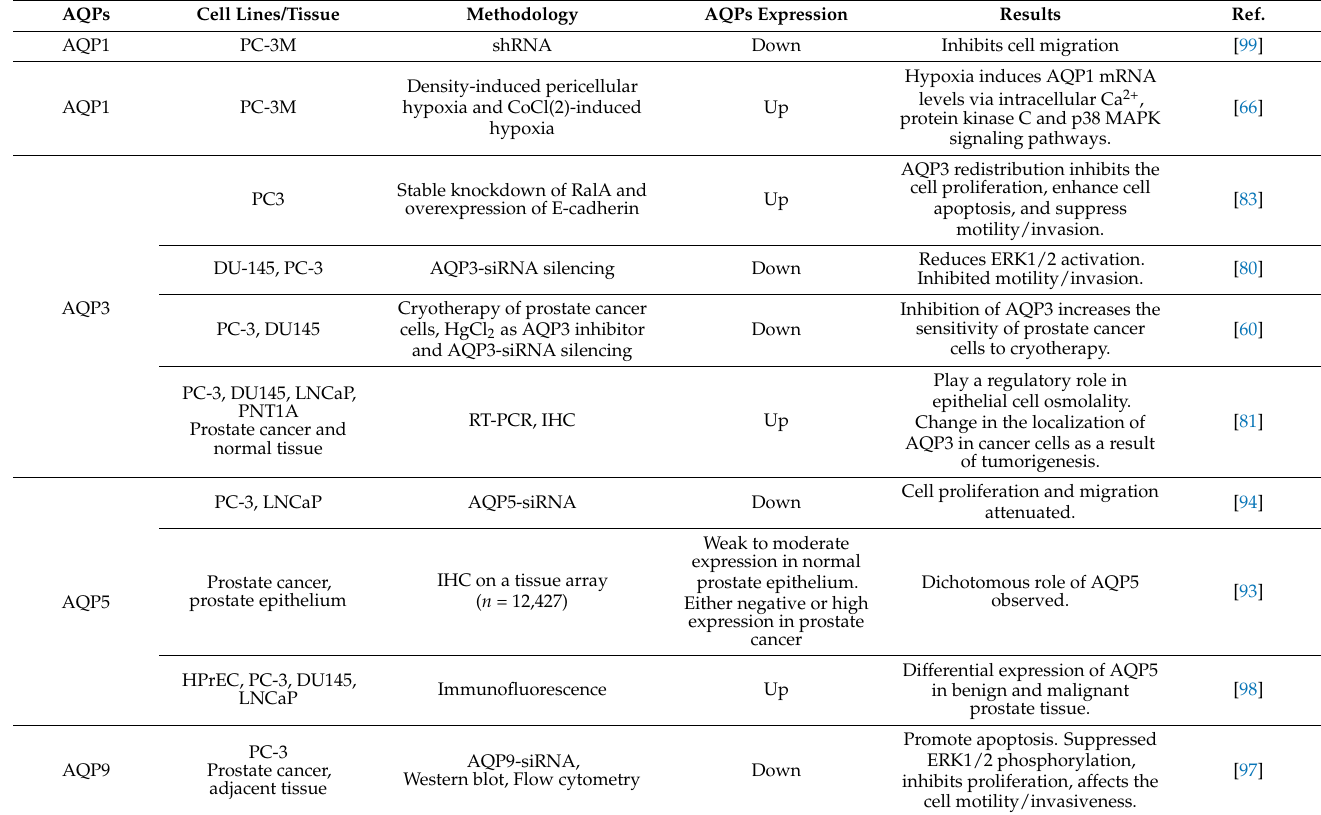
Table 2. Studies conducted on AQPs in prostate